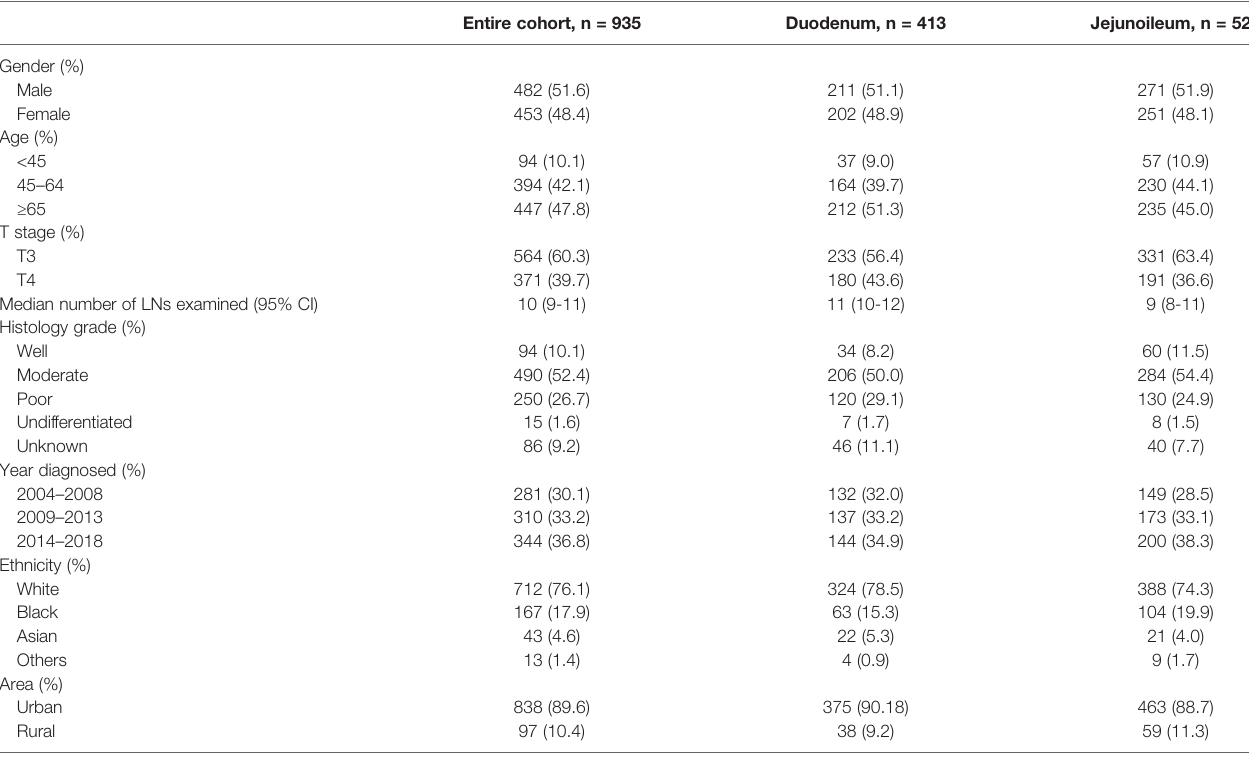
TABLE 1 | Clinicopathological characteristics of patients with small bowel adenocarcinoma.